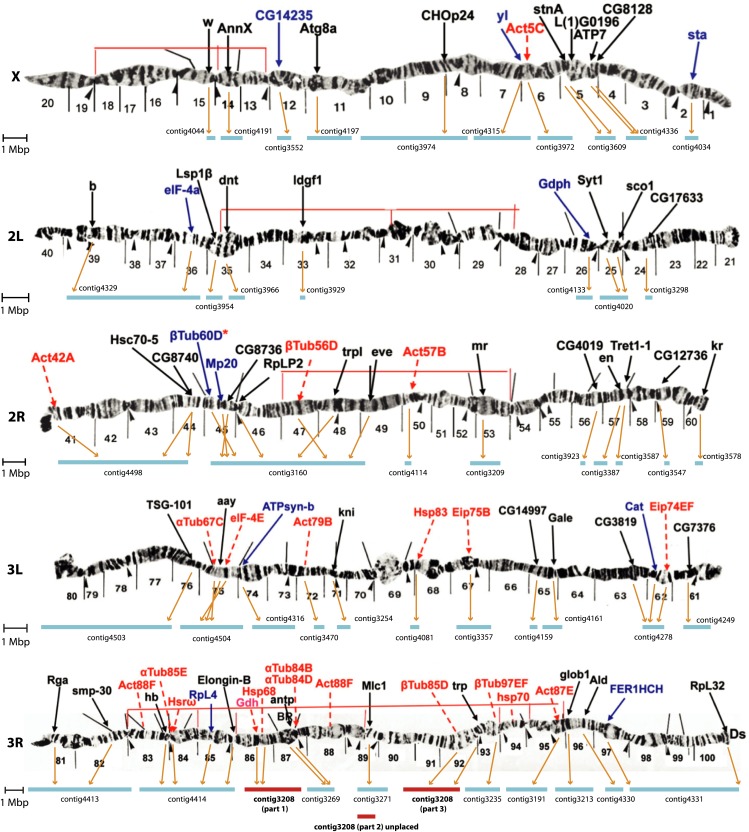
Comparison between the draft genome assembly and the physical D. serrata genome map, image is adapted from Stocker et al. (2012). Genes in red were mapped by Drosopoulou and Scouras (1995, 1998), Drosopoulou et al. (1996, 1997, 2002), and Pardali et al. (1996). Genes in blue are also included in the linkage map produced by Stocker et al. (2012). Thin red lines are inversions found by Stocker et al. (2004) and thin black lines are inversions found by Mavragani-Tsipidou et al. (1990). Contig3208 (shown in red), was split into three parts based on the misassembly; parts 1 and 3 aligned with D. melanogaster 3R and part 2 aligned with 3L (Figure 1). Markers Act88F and hsp70 were not mapped to contigs because the former appears twice and nomenclature changes meant we could not be certain exactly which gene hsp70 was referring to.